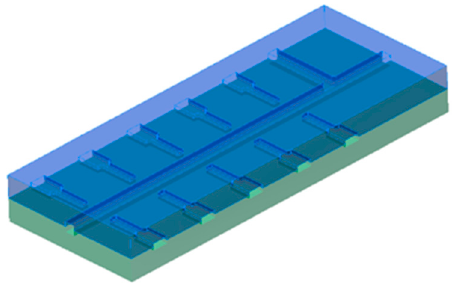
Figure 2. Design of a ceramic microreactor for continuous hydrothermal synthesis (CHTS) which is manufactured from two single parts (blue—top part, green—bottom part) using CIM and subsequent sinter-joining.